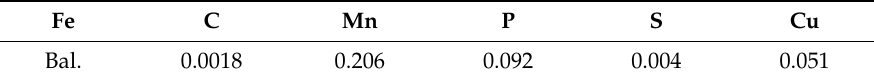
Table 1. Chemical composition of SPCC steel